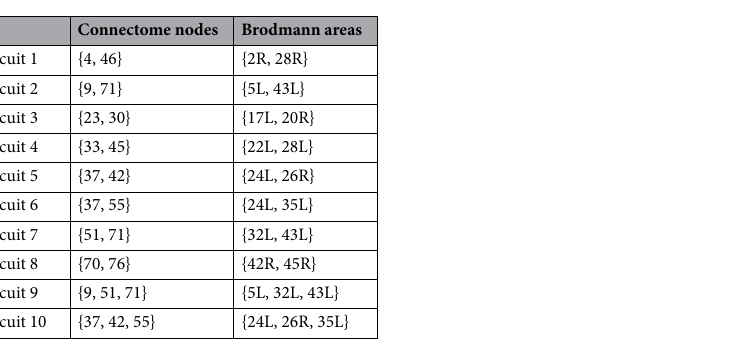
Table 4. Number of involved nodes and circuits for a simulation in which the threshold value was set at 0.87.